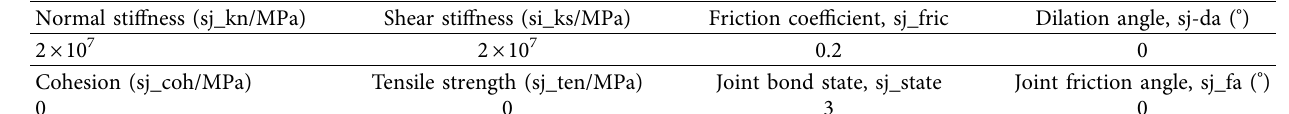
Table 2: Main parameters of joint.